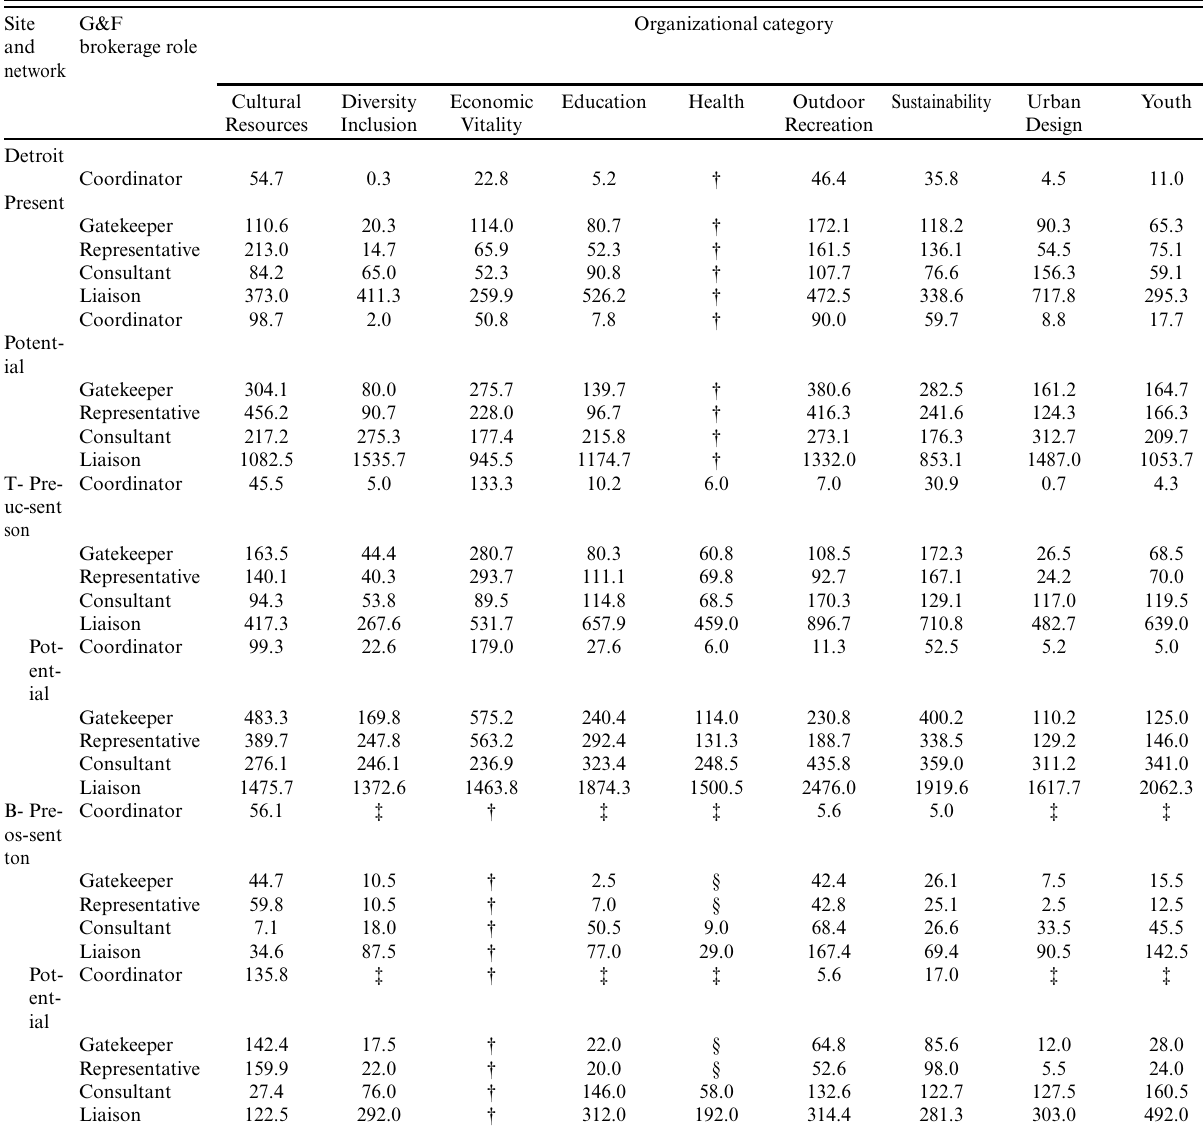
Table 6 . Average number of triads in each G&F brokerage role by organizational category in present and potential National Park Service urban collaborative networks in each